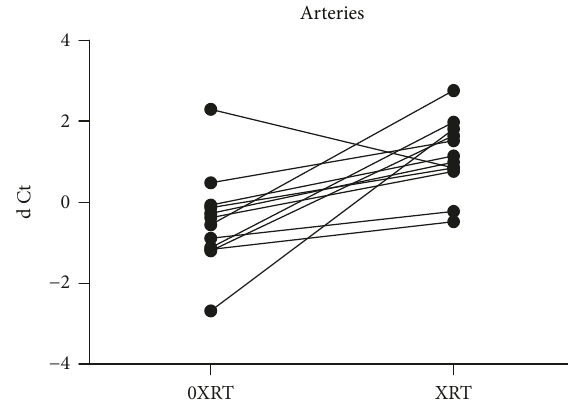
Figure 1: Serpine1 gene (PAI-1) expression is higher in irradiated arteries (XRT) vs unirradiated arteries (0XRT; ddCt), in relation to PGK1 (dCt), p = 0 012 .